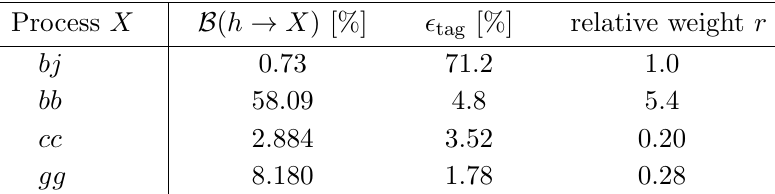
Table 3. Qualitative estimate of the irreducible backgrounds’ relative importance for the leptonic search channels. Higgs branching ratios are taken from [38], while tagging e(cid:14)ciencies (cid:15) tag are B calculated based on eq.